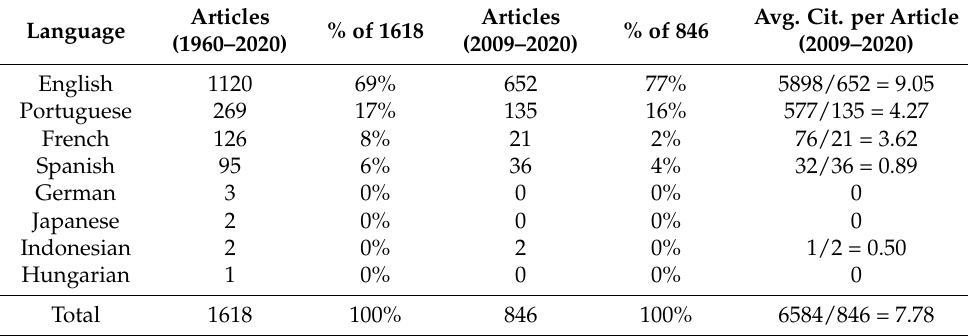
Table 4. Publication languages in coffee agronomy